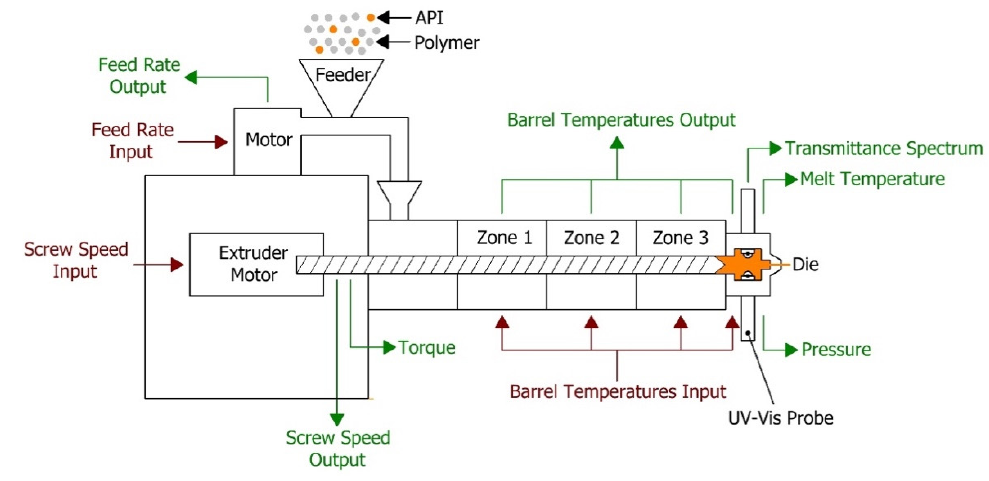
Figure 1. Schematic of the hot melt extrusion process.